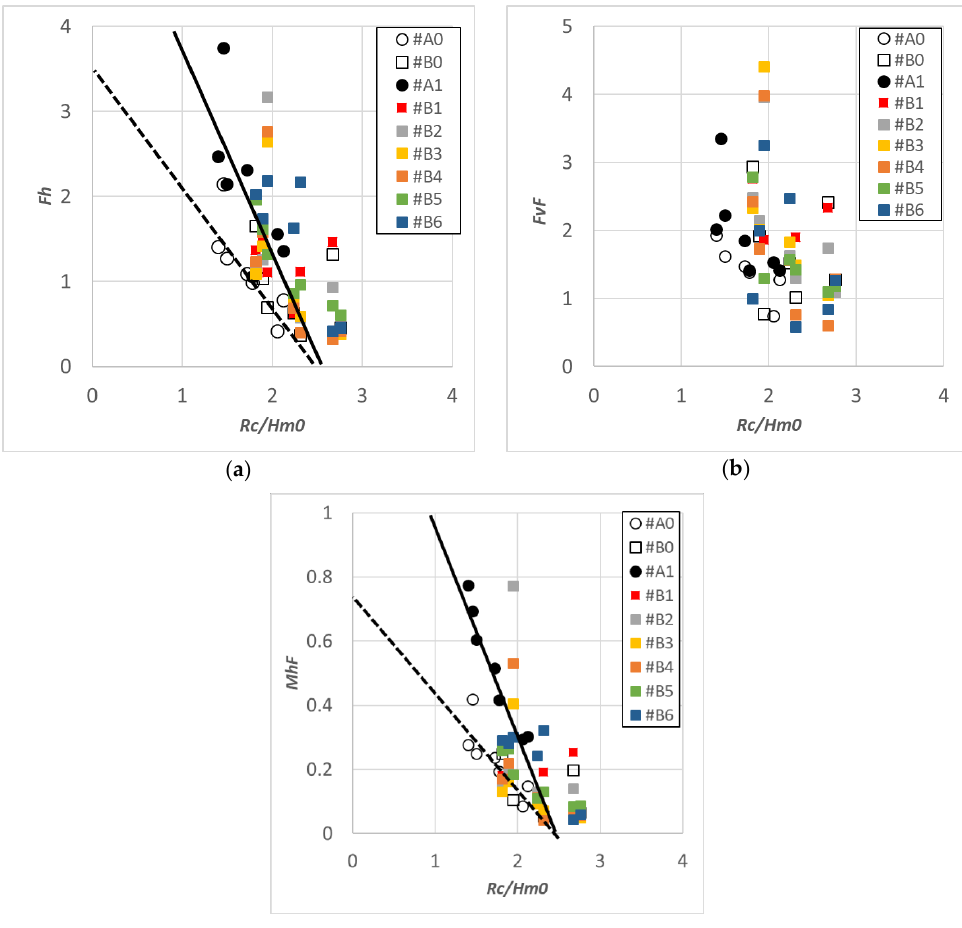
Figure 12. Comparison of ( a ) Fh , ( b ) FvF , and ( c ) MhF with R c /H m0 .